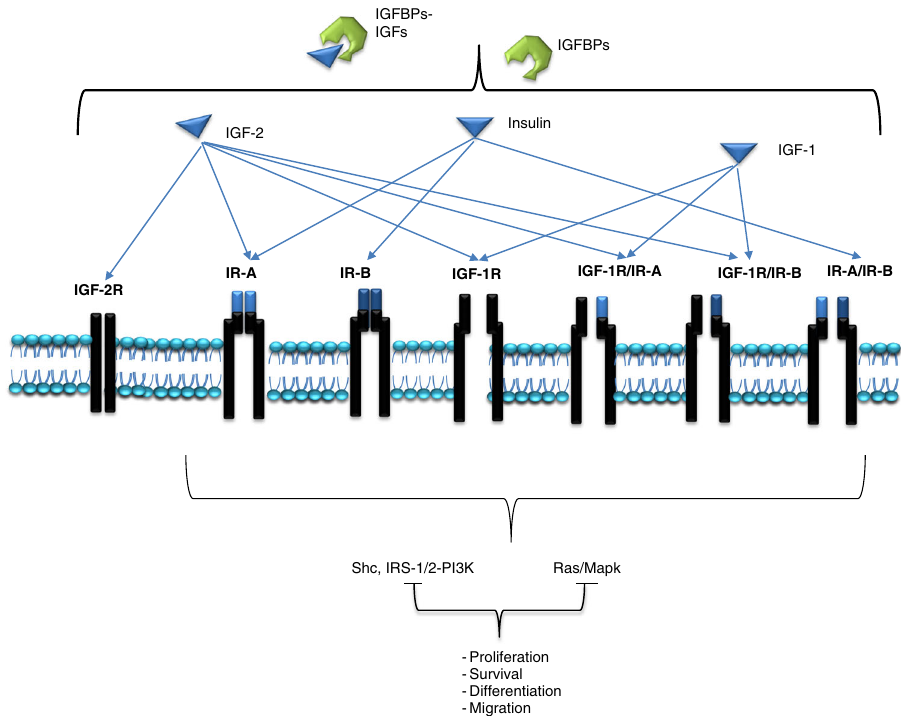
Fig. 1 Schematic representation of the type I IGF-1R and IR signaling network. The network is composed of two principal receptors and three ligands. The receptors are transcribed from a single gene, IGF-1R, and IR. In addition, InsR has two isoforms generated by splice variants of the IR gene, IR-A and IR-B. Each gene transcribes a single protein which is then processed into an α and β subunit. These subunits may form a holoreceptor (IGF-1R, IR-A, IR-B) or the units can form heterodimeric hybrid receptors (IGF-1R/IR-A, IGF-1R/IR-B, IR-A/IR-B). The type II IGF receptor (IGF-2R) is not a signaling receptor, but has a high af fi nity for IGF-2 and is thought to result in the degradation of IGF-2. The IGFs are also complexed with IGFBPs in extracellular spaces. Both IGF-1 and IGF-2 exert their effects through autocrine, paracrine, and endocrine mechanisms, and can activate the IGF-1R and IR pathways. All IGF-1R network receptors are partially similar in their ligand-biding domain, while their intracellular ATP tyrosine kinase-binding domains are nearly identical. The binding of each receptor by their ligands induce the phosphorylation of Shc and IRS-1/2. These adapter proteins transmit signals through the PI3K – AKT1 – mTOR pathway or Ras/MAPK pathway to control cell growth, survival, migration, and